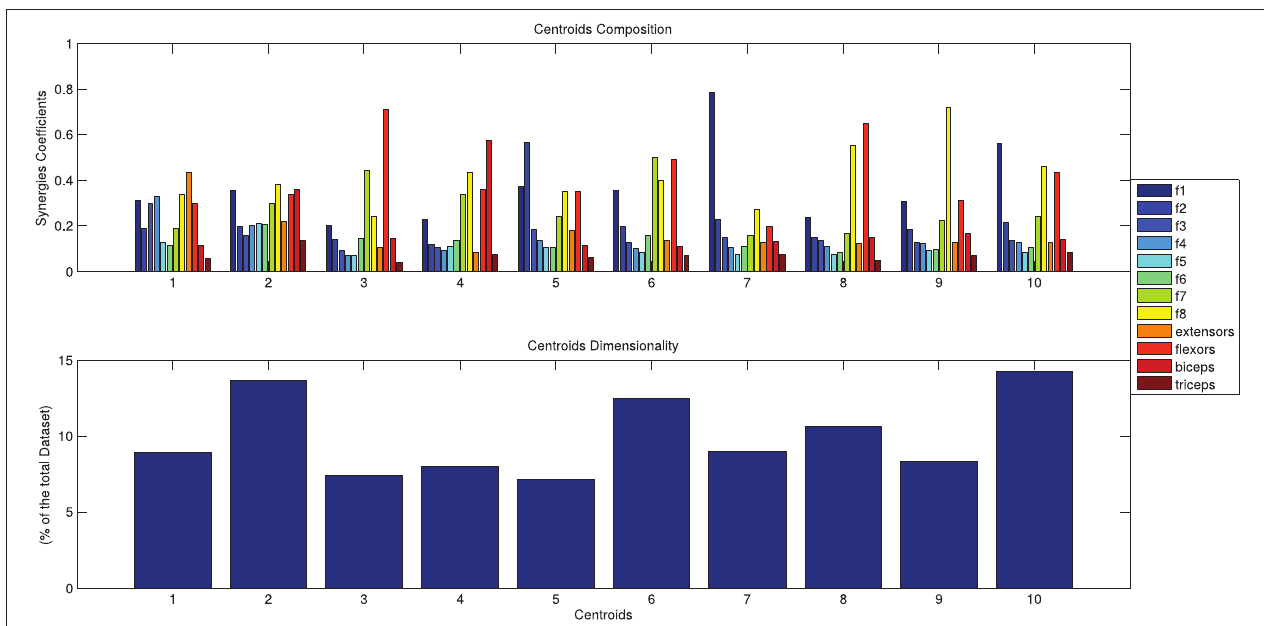
FIGURE 6 | The identified centroids (mean spatial synergies). Hypothesizing a desired maximum error of 0.05 (normalized in respect to the solution of order 1), a solution of 10 clusters is found. Ten motor modules are thus enough to describe with good level of precision the original dataset. The 10 clusters composition are reported in (A) , along with the number of elements belonging to each cluster, expressed as percentage of the original dataset, in (B)